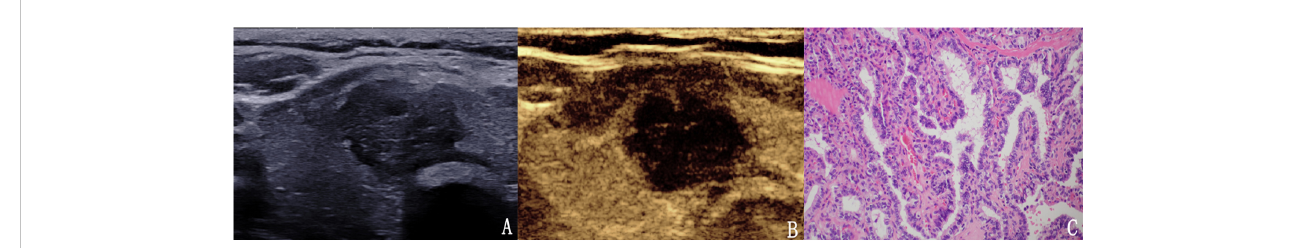
FIGURE 7 The case of a 51-year-old woman with a 20.4 × 15.1 × 16.9 mm solid mark hypo-echoic nodule in the right lobe of the thyroid. (A) Conventional two- dimensional image showing that the nodule had three malignant indicators (solid, mark hypo-echoic and irregular margin) and was classi fi ed with a TI- RADS score of 4b. (B) Ultrasound contrast image showing low enhancement. The modi fi ed version of the TI-RADS combined with CEUS returned a score of 5, and the diagnosis indicated a malignant nodule. (C) Pathological image of the lesion, a PTC.